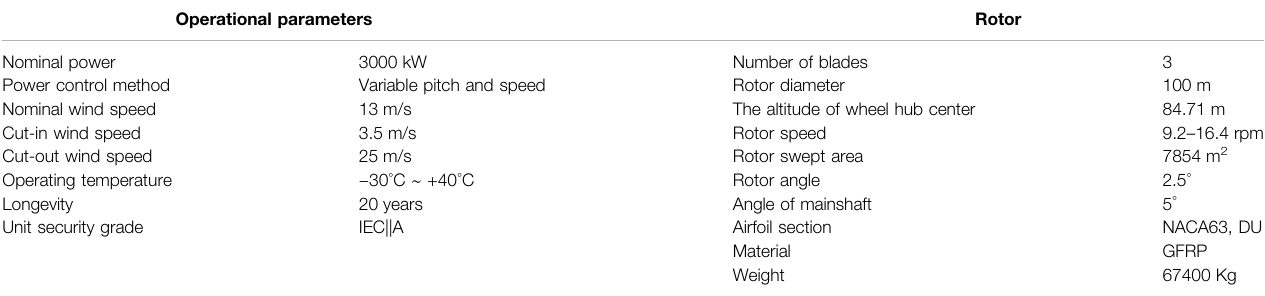
TABLE A1 | 3 MW double-fed induction wind generator technical